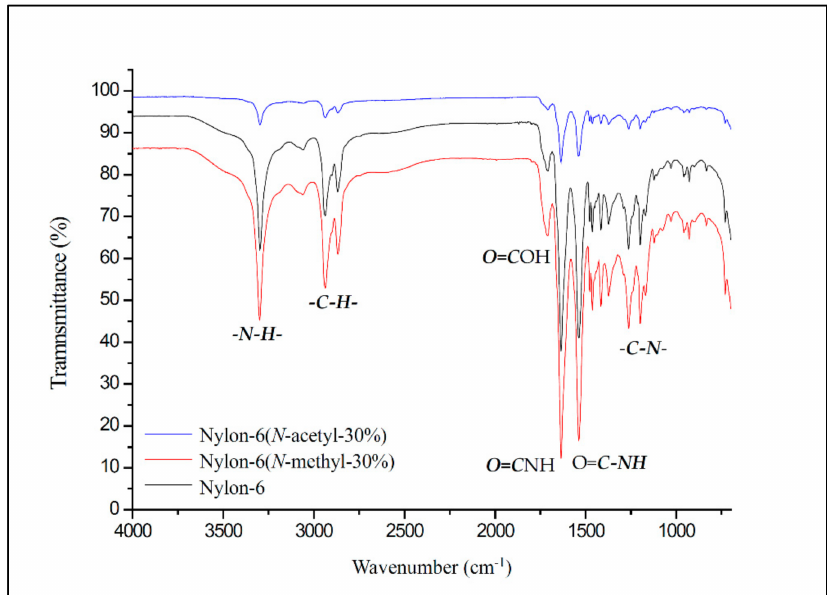
Figure 3. FT-IR spectra of nylon-6, nylon-6( N -methyl-30%), and nylon-6( N